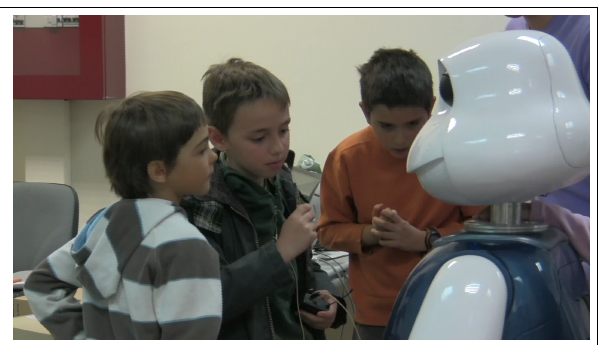
Figure 4. Groupal interaction.